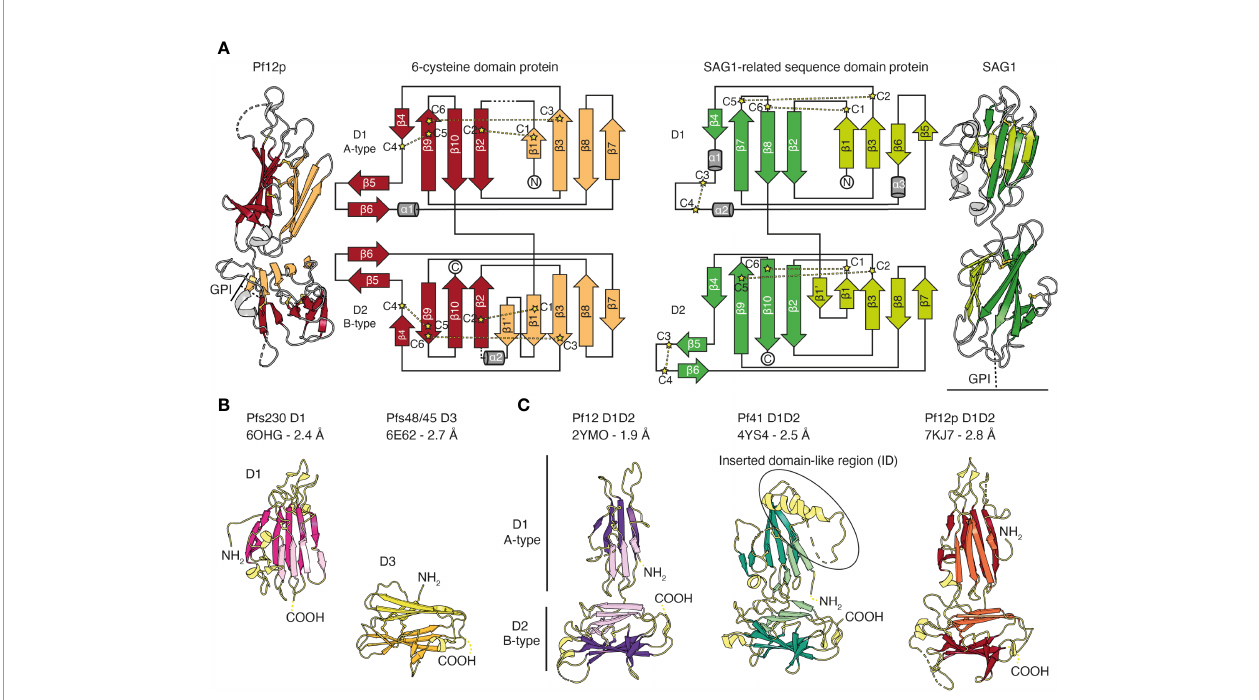
FIGURE 2 | The structural scaffold of 6-cysteine domains. (A) Schematic representation of 6-cysteine protein Pf12p with its N-terminal A-type 6-cysteine domain (D1) and C-terminal B-type 6-cysteine domain (D2). The b -strands of the top b -sheet of the b -sandwich are colored orange and the bottom b -sheet are colored red. Cysteines forming disul fi de bonds are shown in ball-and-stick representation in yellow (PDB ID 7KJ7). Dotted lines indicate unmodeled regions. Topology diagram of Pf12p colored similarly to the schematic representation. Disul fi de bond connectivity is indicated by yellow lines. Topology diagram and schematic representation of SAG1 from Toxoplasma gondii , the prototypic member of the SRS-superfamily (right, PDB ID 1KZQ). The b -strands of the top b -sheet of the b -sandwich are colored light green and the bottom b -sheet are colored green. (B) Crystal structure of single 6-cysteine domains of Pfs230 D1 (left) and Pfs48/45 D3 (right). (C) Crystal structures of 6-cysteine proteins containing a tandem pair of A- and B-type 6-cysteine domains. PDB IDs with corresponding resolution, N-terminal domain 1 (D1), C-terminal domain 2 (D2) as well as N- and C-termini are indicated (NH2 and COOH,